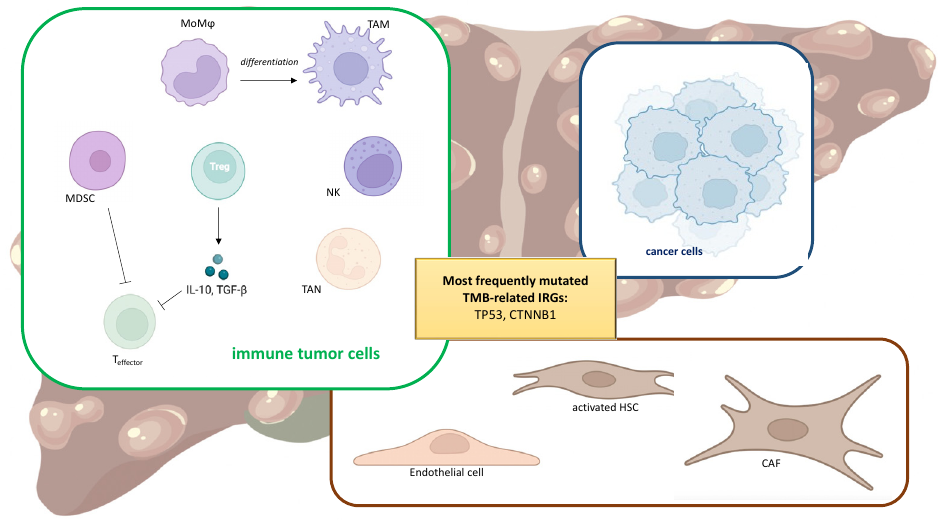
Figure 2. Main cells populating the tumor microenvironment, i.e., monocyte-derived macrophages (MoM φ s) differentiating into tumor-associated macrophages (TAMs), myeloid-derived suppressor cells (MDSCs), tumor-associated neutrophils (TANs), natural killer cells (NKs), regulatory T cells (Tregs), and cytotoxic CD8+ T (Teffector), as well as cancer-associated fibroblasts (CAFs), hepatic stellate cells (HSCs), and endothelial cells. TP53 and CTBBN1 are the two genes most frequently mutated showing a correlation with TMB.